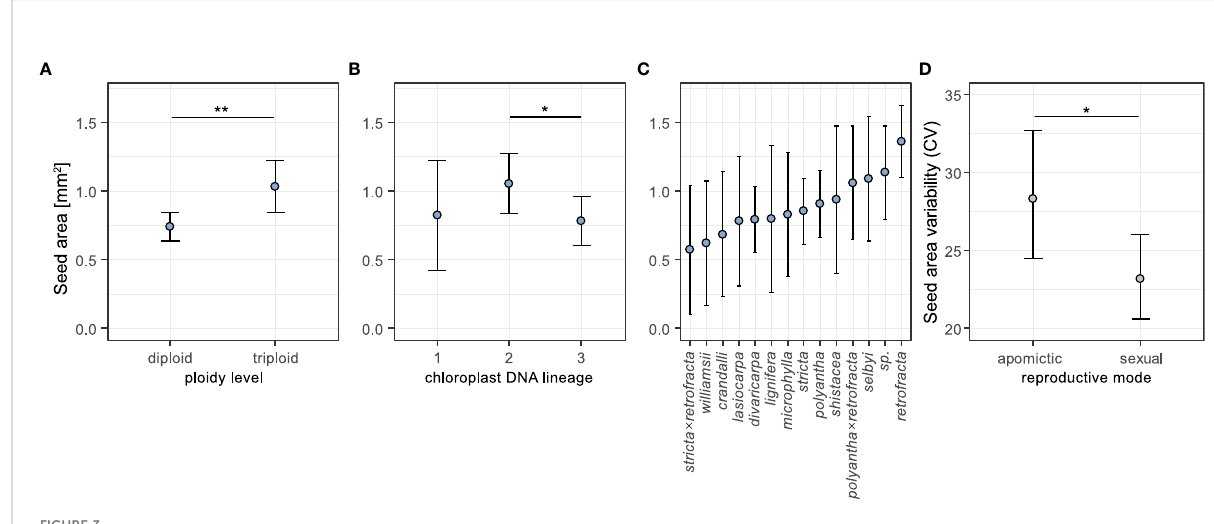
FIGURE 3 Effects of ploidy level (A) , chloroplast DNA lineage (B) and species (C) on seed area, and effects of reproductive mode on seed area coef fi cient of variation (D) estimated from general linear mixed-effect models (see text for details of GLMMs). In the analysis of seed area for each of the three factors the estimated means were averaged over the levels of the other two factors using weights proportional to their frequencies in the data set. Error bars represent 95% con fi dence intervals. Signi fi cance levels: ∗ < 0.05, ∗∗ < 0.01, ∗∗∗ <